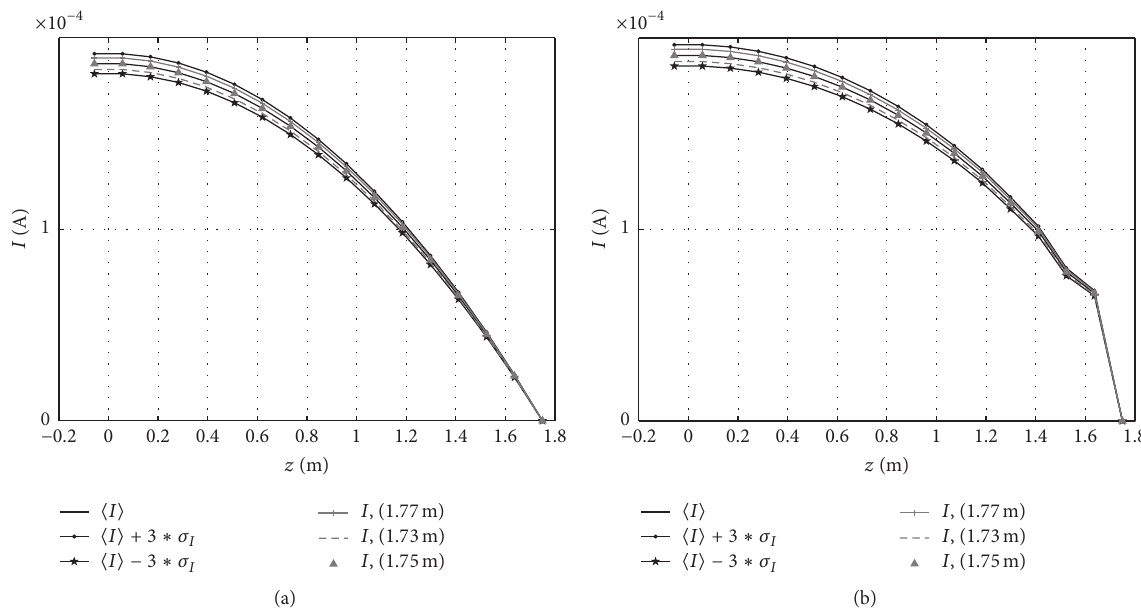
Figure 3: Induced axial current in the human body with length 𝐿 as RV: ⟨𝐼⟩ is stochastic expected value, 𝜎 𝐼 is standard deviation, and 𝐼 is the value obtained from analytical (a) and numerical deterministic model (b).